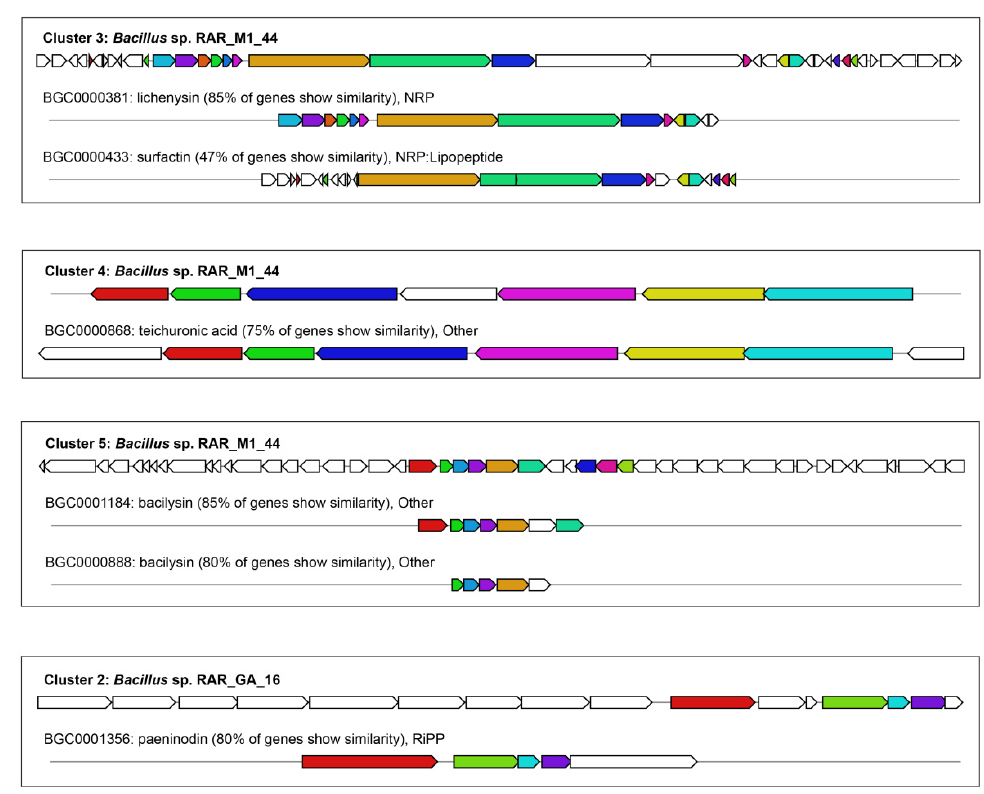
Figure 3. Similarity of predicted BGCs from genomes and the MIBiG database.